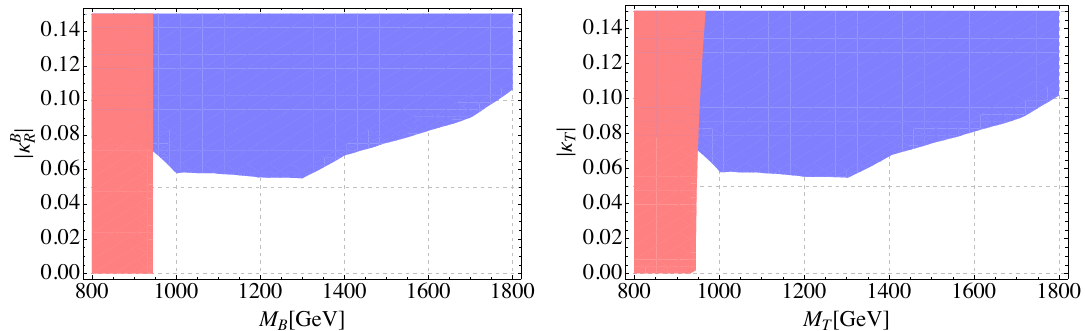
Figure 1 . Existing constraints on the parameters of the simplest VLQ realisation featuring extra quarks coupling to the (cid:12)rst generation of SM quark and the Higgs boson, as extracted from the CMS search of ref. [30]. The bounds are equivalently shown in the ( (cid:20) B plane (right). The red area is excluded by the search for a strongly produced pair of VLQs, while the blue area shows the additional exclusion arising from the search for a singly-produced B